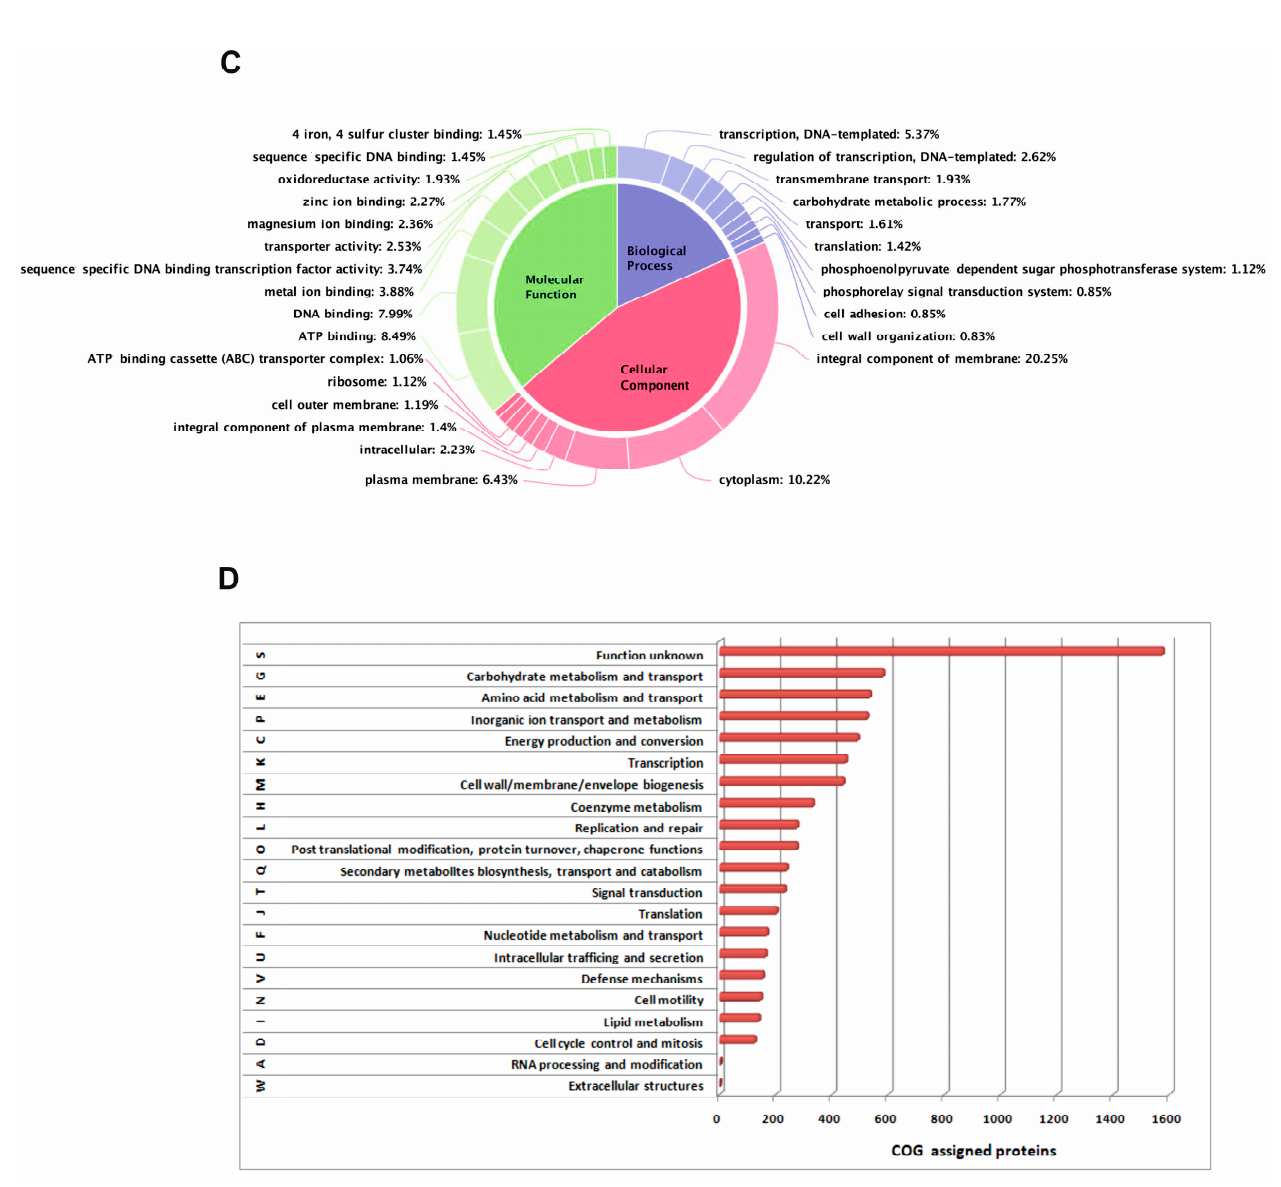
Figure 1. ( A ). The core genome multilocus sequence typing-based phylogenetic relationship tree was constructed for all of the available Indian E. coli strains in the BacWGSTdb server from different hosts, and ST groups were compared with the reference ST540 E. coli _ AZ147 strain. Grape tree displayed the relationship between isolates and comprised two major cluster groups. The E. coli ECU32 strain highlighted with a yellow circle with black center was found to be associated with human isolates in the second cluster. The lengths of all branches are scaled logarithmically. The numbers mentioned in square brackets are isolates from a range of hosts. ( B ). Grape tree represents the phylogenetic relationship of available E. coli ST540 strains in BacWGSTdb from different isolation sources and countries. The strain name was mentioned along the colored circle, the color indicates the source of isolation, and the isolate counts are mentioned in brackets. The E. coli ECU32 strain was highlighted with a yellow circle. The node label represents the allele differences, and the branch lengths are scaled logarithmically. ( C ). Gene ontology annotation of predicted genes was performed using BLAST analysis, and top gene ontologies were classified into cellular components, molecular functions, and biological process. ( D ). Distribution of clusters of orthologous groups (COG) in E. coli ECU32. The homologous gene clusters were functionally categorized and classified with COG